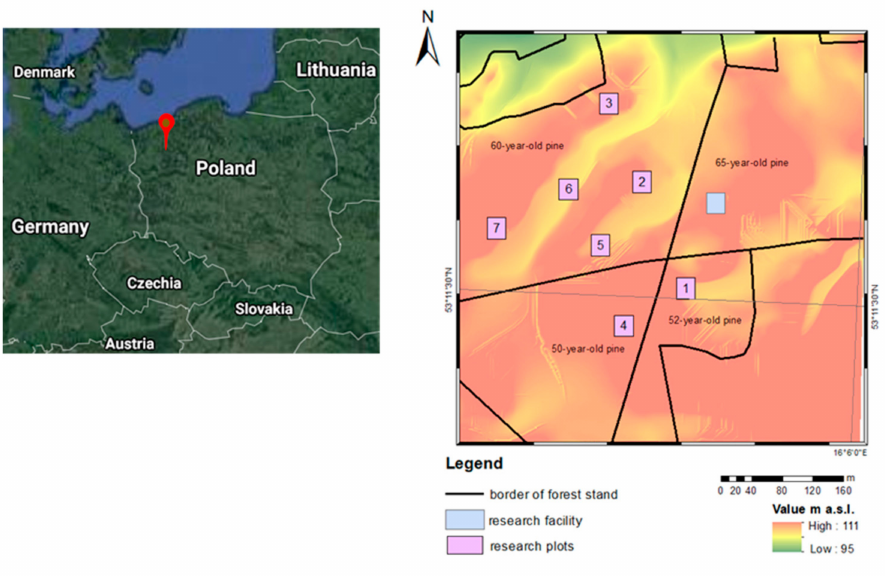
Figure 1. Space arrangement of research plots in Tuczno research